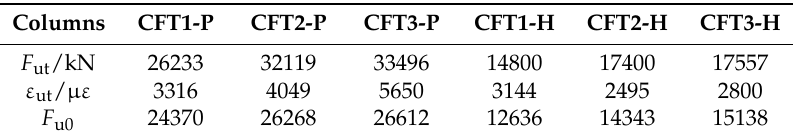
Figure 8. Tested F ‐ε curves and backbone curves of specimens. Table 3. Peak results of specimens.